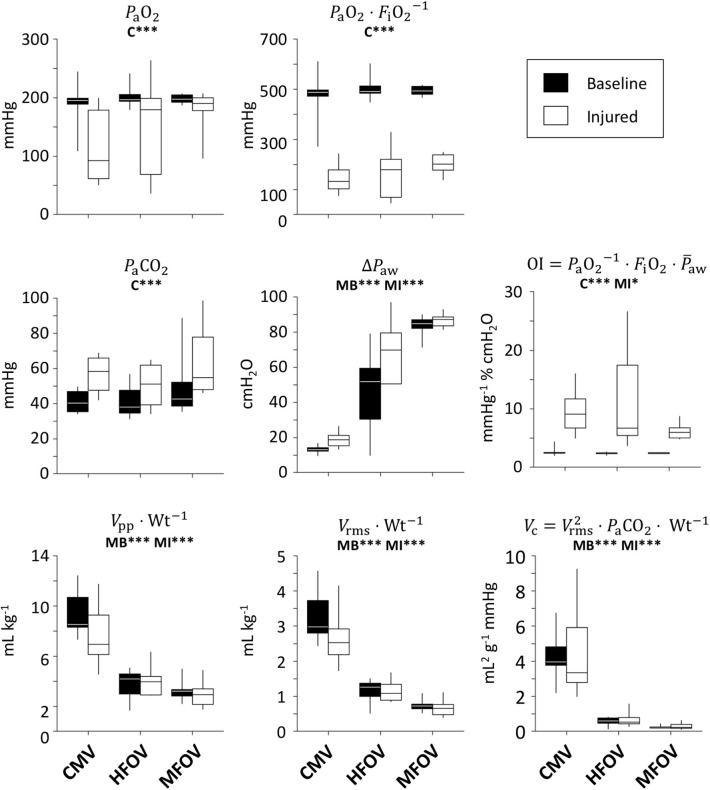
Gas exchange outcomes, represented by box plots showing minimum, maximum, and quartiles across subjects under baseline (black) and injured (white) conditions, during conventional mechanical ventilation (CMV), high-frequency oscillatory ventilation (HFOV), and multi-frequency oscillatory ventilation (MFOV). Asterisks indicate significance levels (*p < 0.05, ***p < 0.001) for main effects (C = lung condition, MB = modality for baseline condition, MI = modality for injured condition). See Table 2 for additional clarification. PaO2 = arterial oxygen tension; FiO2 = fractional inspired oxygen; PaCO2 = arterial carbon dioxide tension; ΔPaw = airway pressure amplitude; Vpp = peak-to-peak volume range; Wt = body weight; Vrms = root-mean-square volume.